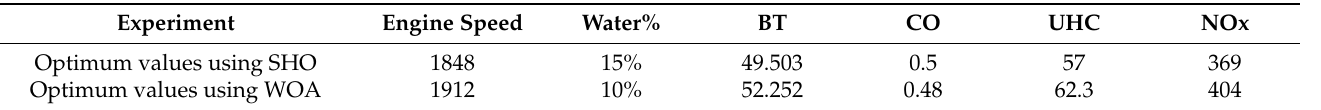
Table 10. Summary of multi-objective optimization results for all BT, CO, UHC, and NOx for various engine speeds and percentages of adding water to the fuel